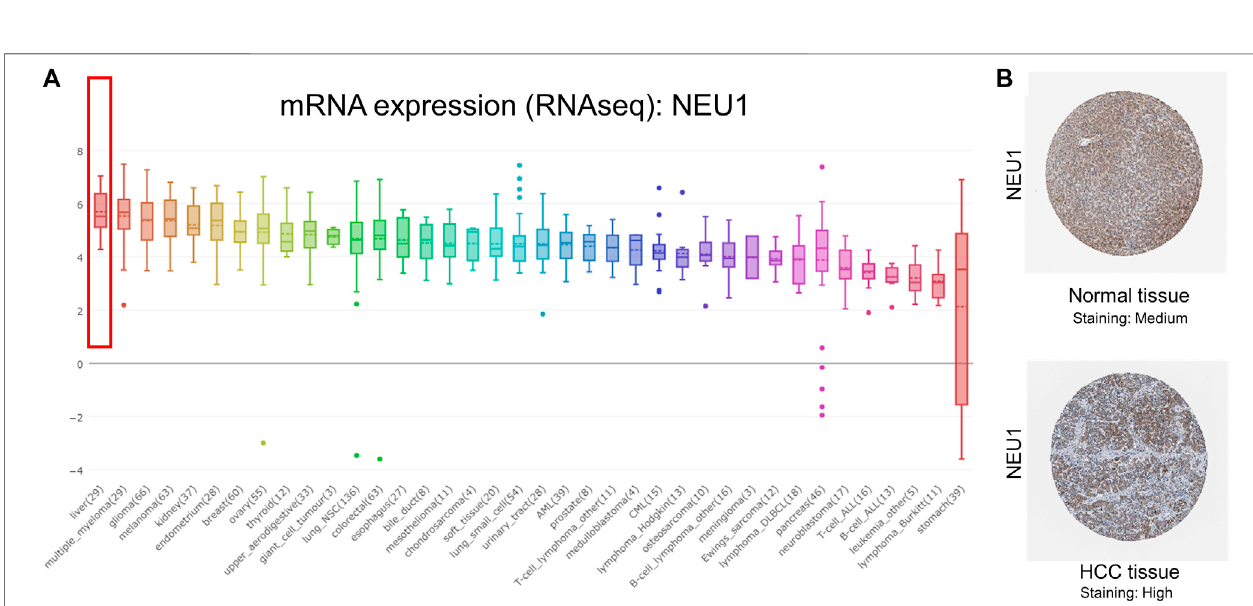
FIGURE 3 | Results from the Cancer Cell Line Encyclopedia (CCLE) and Human Protein Atlas (HPA) analyses of NEU1 (A) NEU1 was highly expressed in liver cancer cell lines (top 1) (B) Representative images of the immunohistochemical staining of NEU1 in HCC tissue and normal liver tissue (Antibody: HPA015634). Medium protein expression of NEU1 was found in normal liver tissue, while high protein expression was observed in HCC tissue.